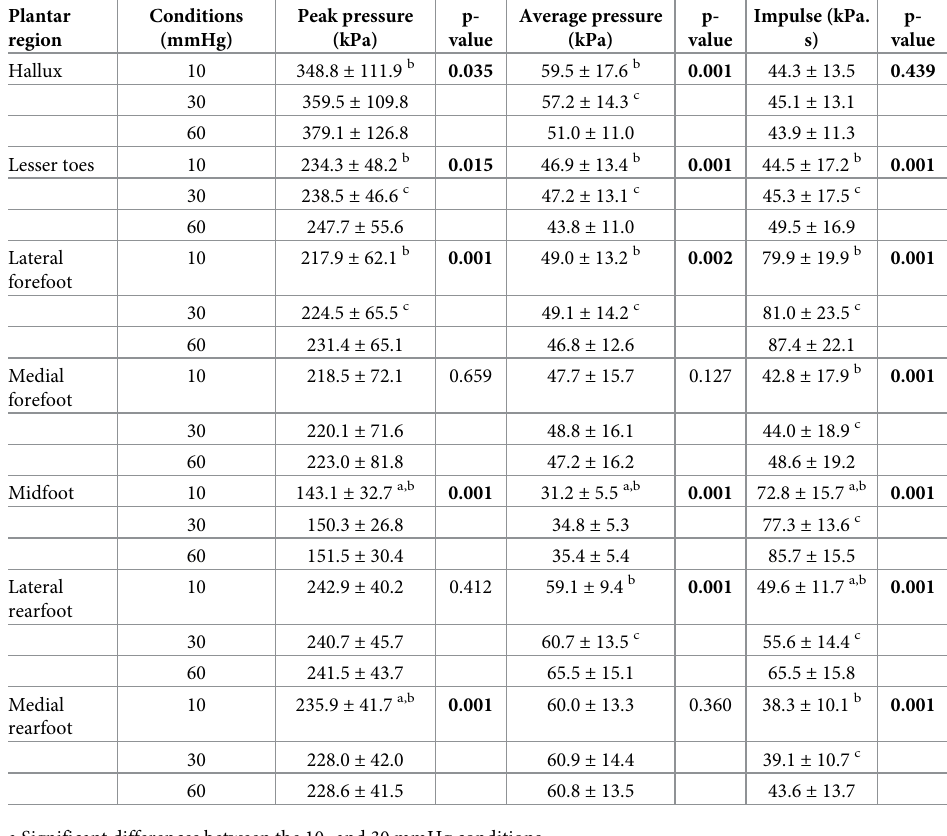
Table 3. Plantar pressure parameters when walking with three shoe conditions (mean ±